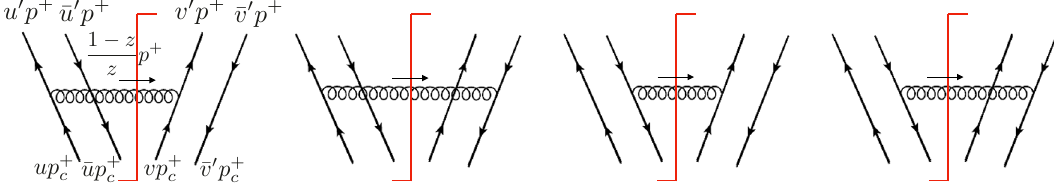
Figure 2 . Real emission diagrams for computing partonic fragmentation functions at order (cid:11) s for light-cone gauge. We label the (cid:13)ow of + components of momentum to make z; u; v; u 0 ; v 0 variable dependence explicit. For the full momentum dependence and details of the computation, see ref.